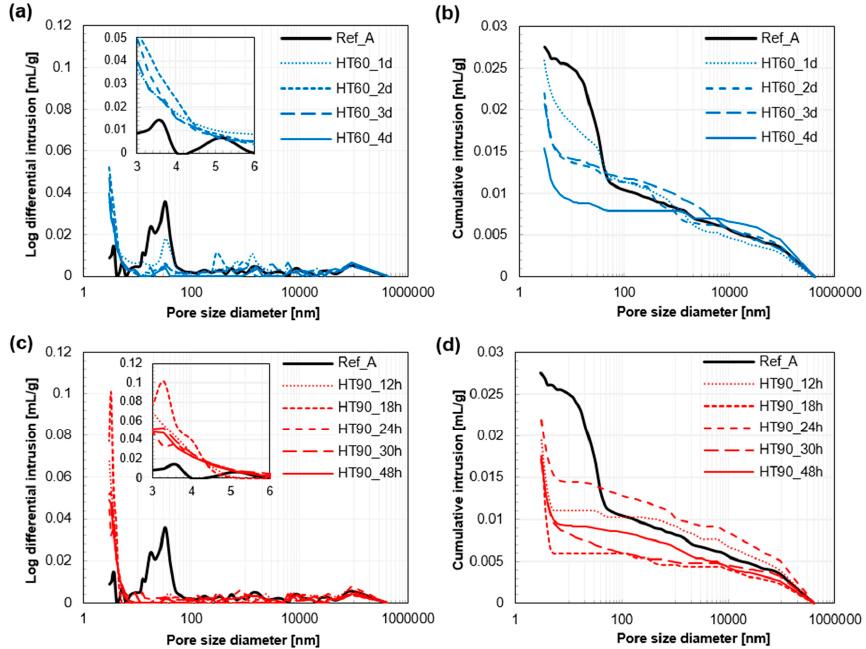
Figure 7. Pore size distribution of UHPC at 28 days: Log differential intrusions ( a ) and cumulative pore volume ( b ) of Ref_A and HT_60 series. Log differential intrusions ( c ) and cumulative pore volume ( d ) of Ref_A and HT_90 series.